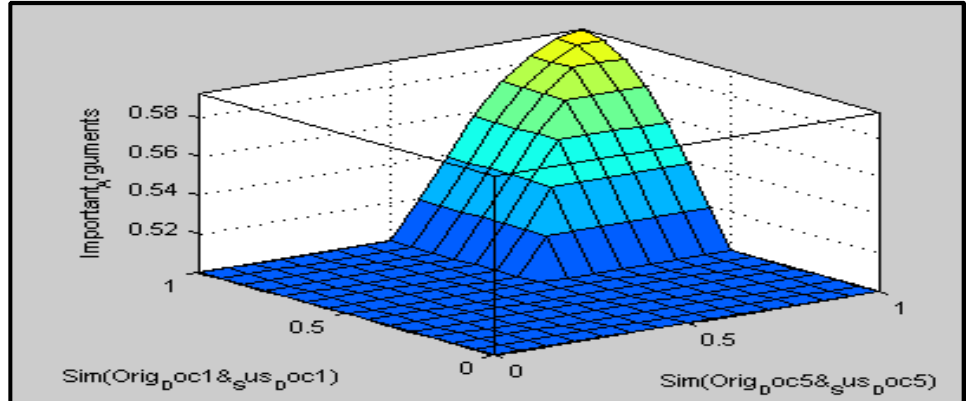
Figure 7. Important argument similarity using fuzzy model.